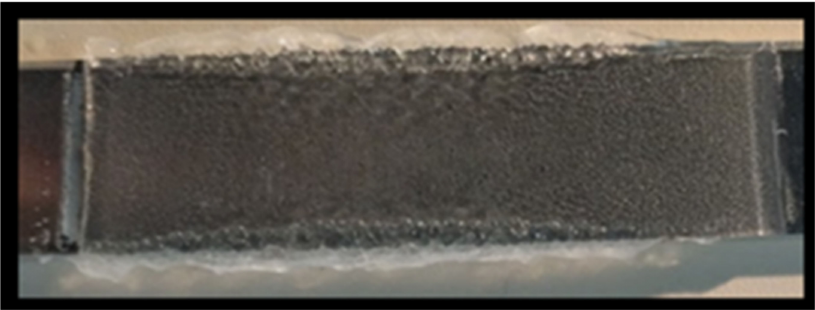
Figure 17. Image of glaze ice obtained in the IWT on a flat